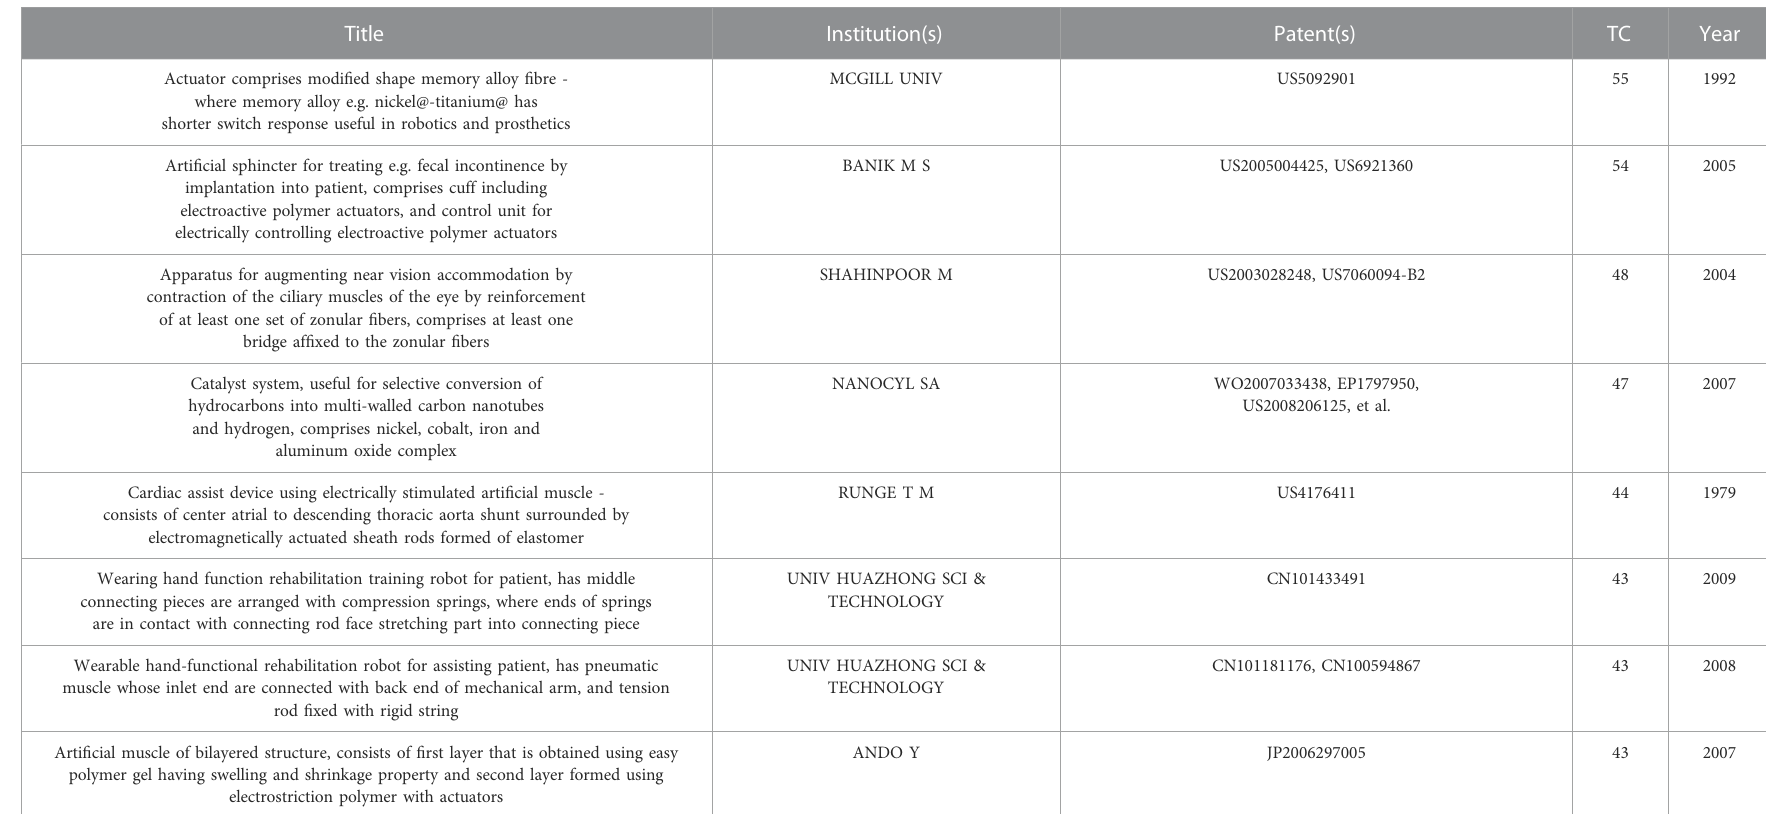
Institution(s) Patent(s) TC